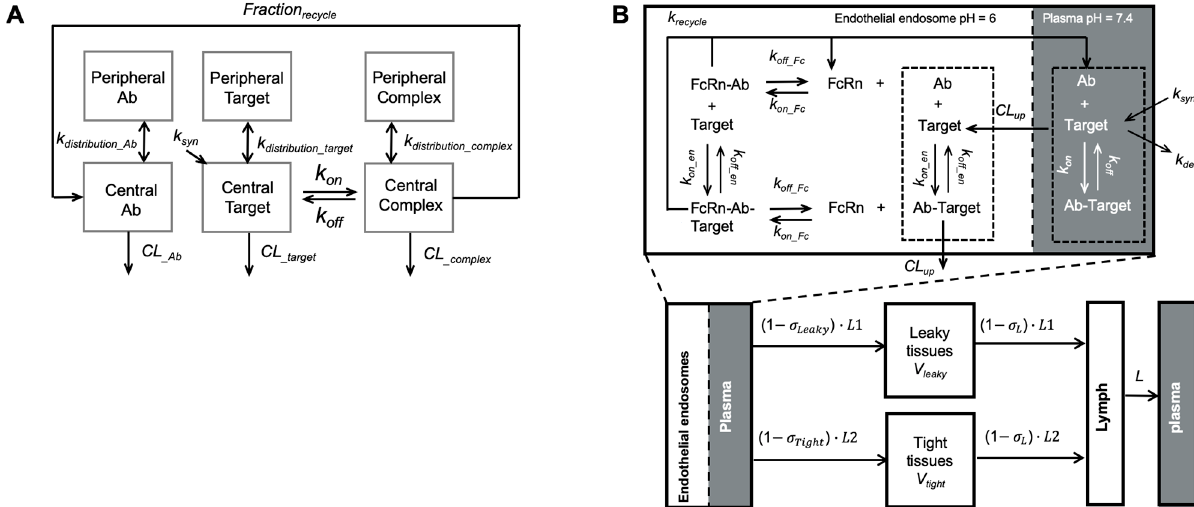
Figure 6. Modeling recycling antibodies. ( A ) A target-mediated drug disposition (TMDD) modified to include a fraction of recycling. The model included the distribution kinetics of recycling antibodies, pathogenic targets, and antibody complexes between the central and peripheral compartments. The antibody-target binding was only considered in the central compartment. F rec described the FcRn-mediated recycling, the fraction of antibody recycled from endosome (Adapted modified from Figure 1 [81], Elsevier, 2016). ( B ) A minimal-PBPK model with a nested endosomal compartment describing the binding kinetics of recycling antibodies. The antibody-target binding was included in both plasma (shadowed) and endosome compartments. FcRn-mediated antibody recycling was considered in the endosome compartment. (Adapted from Figure. 1 [25], Springer Science, 2018).